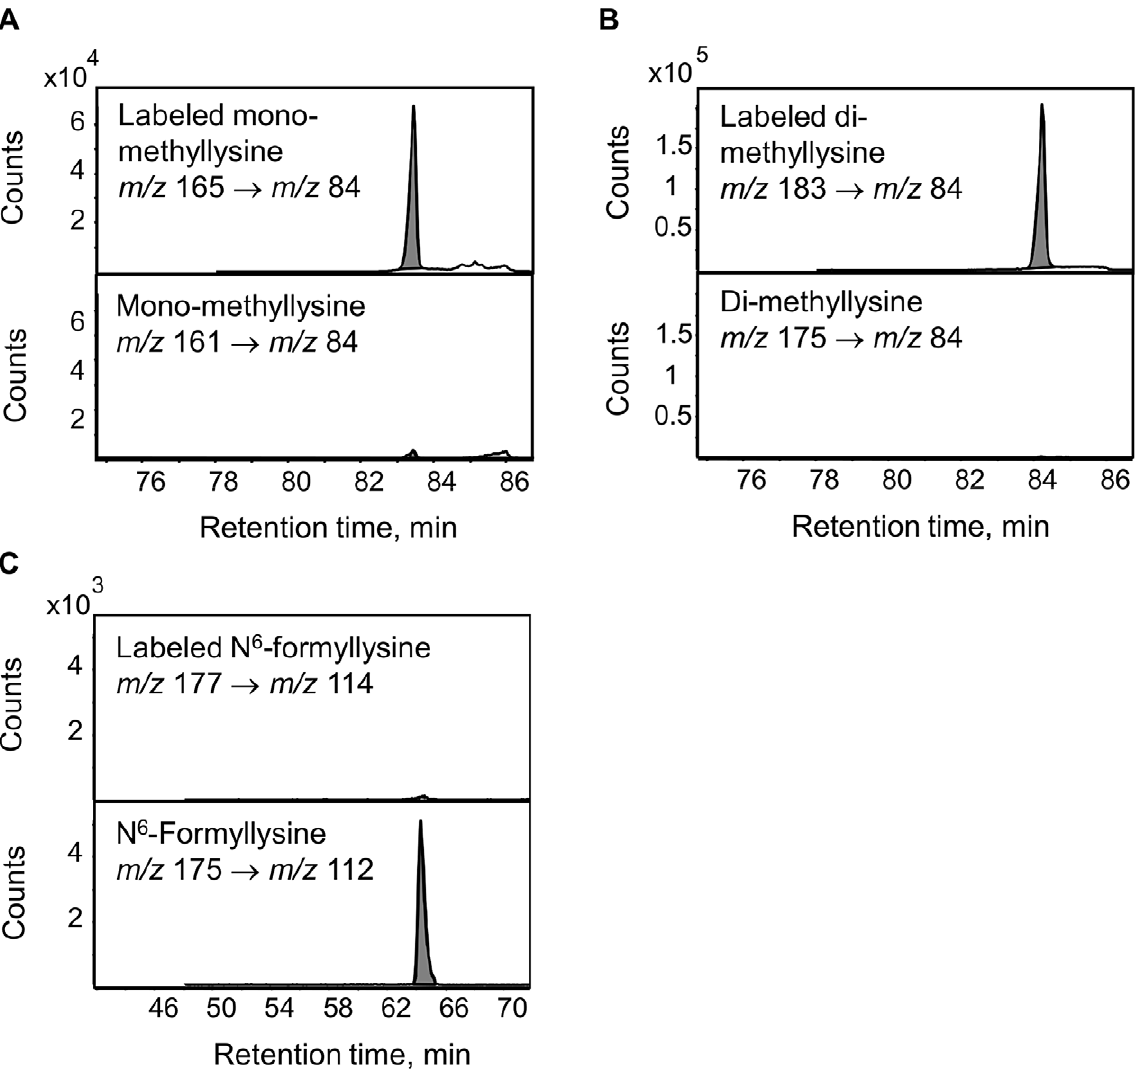
Figure 5. Analysis of lysine demethylation as a source of N 6 -formyllysine. Methyl groups in N 6 -methyllysine species in TK6 cells were labeled using L-methionine-([ 13 C, 2 H 3 ]-methyl) and N 6 -formyllysine and N 6 -methyllysine species were quantified by LC-MS/MS as described in Materials and Methods . Panels A and B: N 6 -mono-methyllysine and N 6 -di-methyllysine are predominately labeled ( . 90%) with heavy isotope methyl groups (mass increase of 4 m/z and 8 m/z , respectively), with , 10% of the modifications containing unlabeled methyl groups. Panel C: the level of N 6 - [ 13 C, 2 H]-formyllysine (177 m/z R 114 m/z transition) in histones did not show an increase beyond the natural isotope abundance level of , 0.7% for [M + 2] ion of N 6